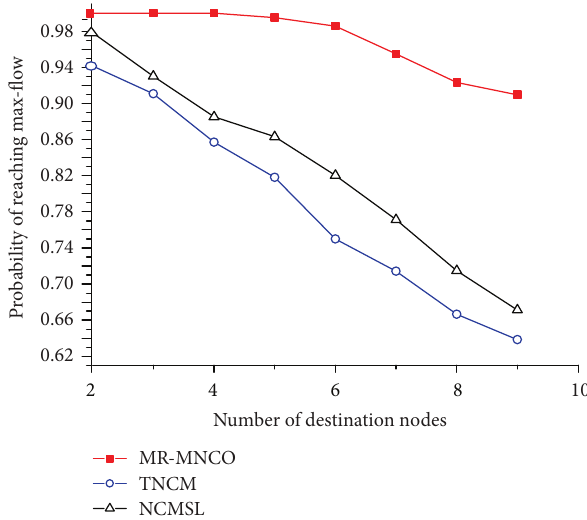
Figure 4: Network coding operations versus number of destination nodes.